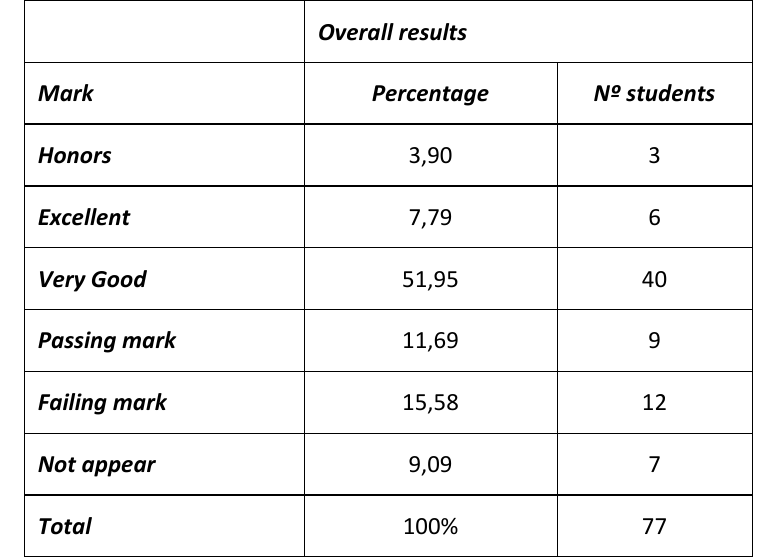
Table 5: Percentage distribution of total student marks